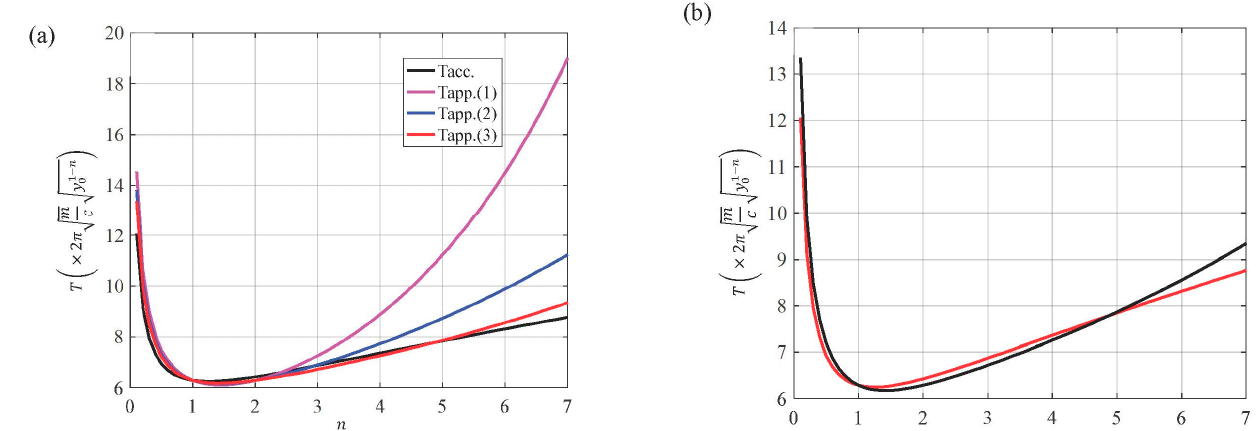
Figure 2. ( a ) The T = f ( n ) functions using the accurate solution (Equation (21)) and the approximate Equations (26), (28) and (30). ( b ) The T = f ( n ) functions using Equation (21) (black curve) and (30) (red curve). Equation (30) is the more accurate approach in this case.